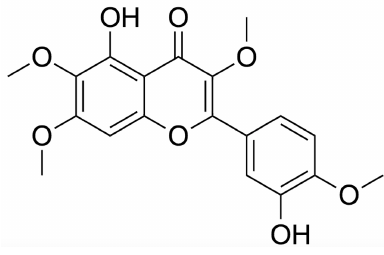
Figure 1. Molecular structure of casticin.